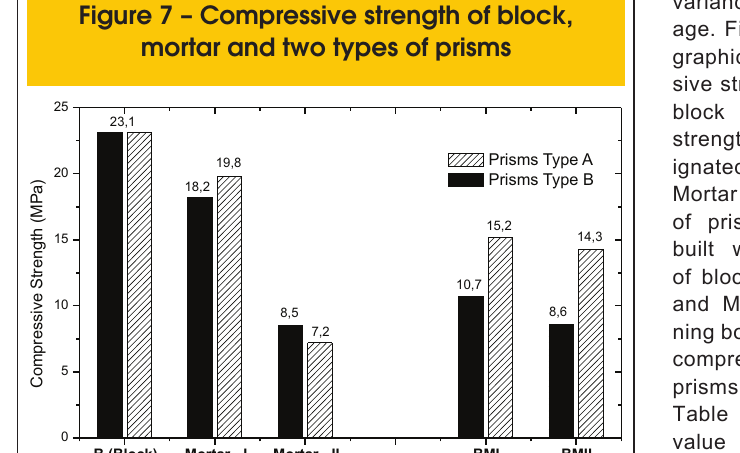
Figure 7 – Compressive strength of block, mortar and two types of prisms